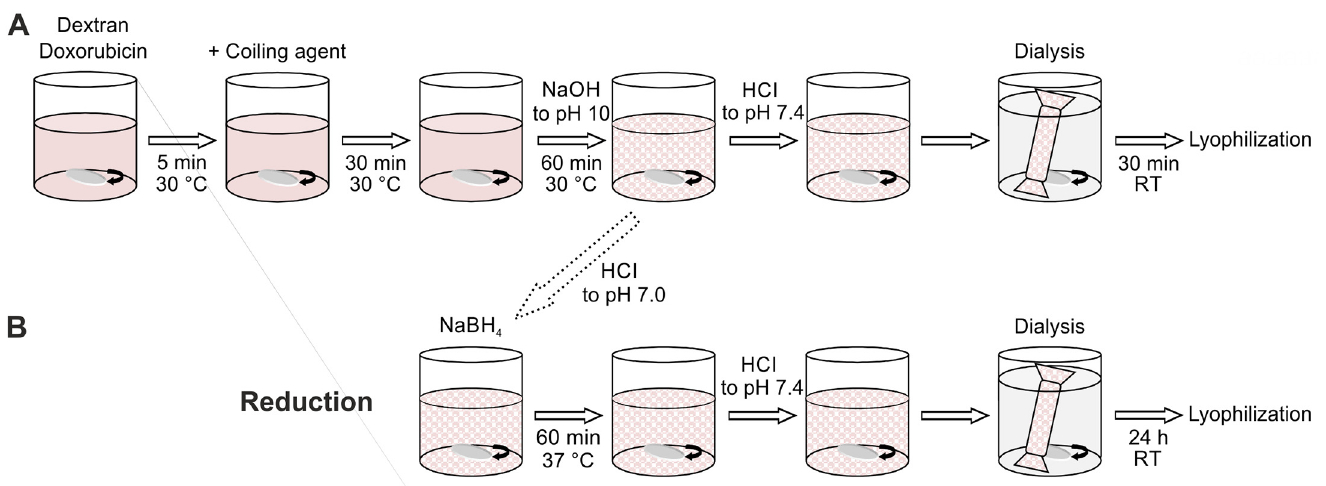
Fig 1. Diagram of nanoparticles synthesis